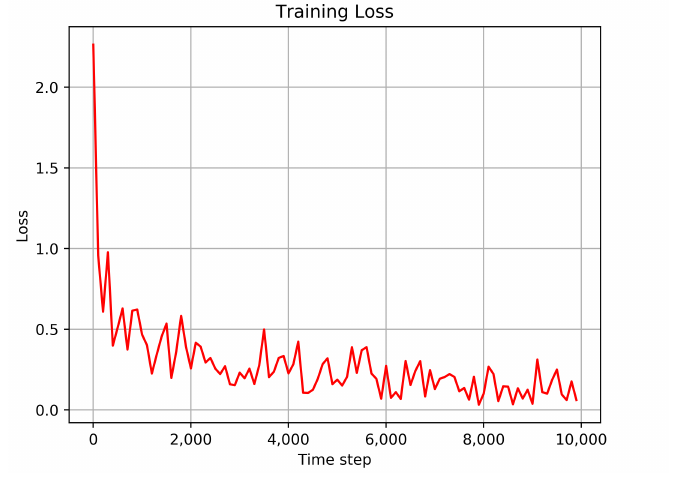
Figure 7. Training loss